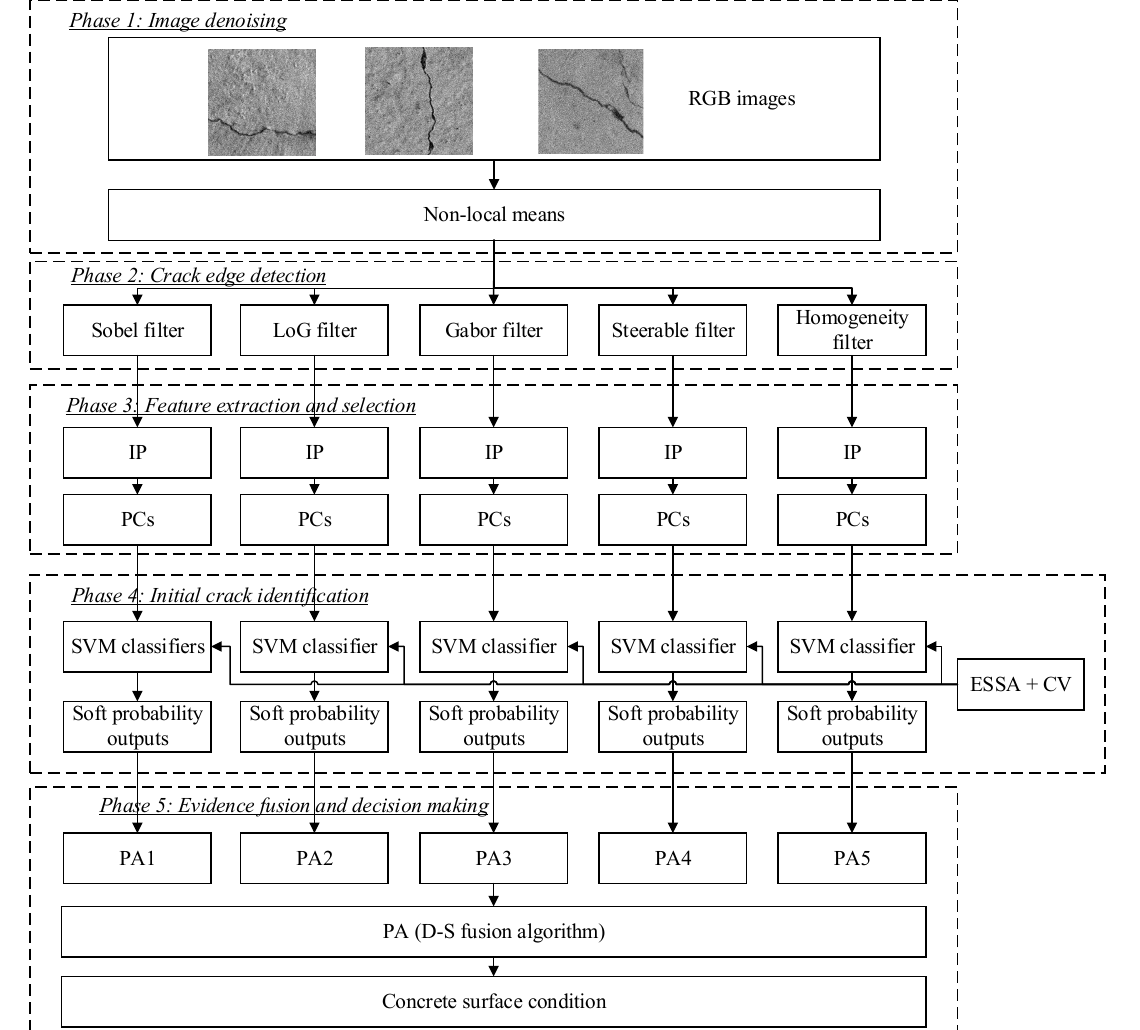
Figure 2. Proposed hierarchical framework.